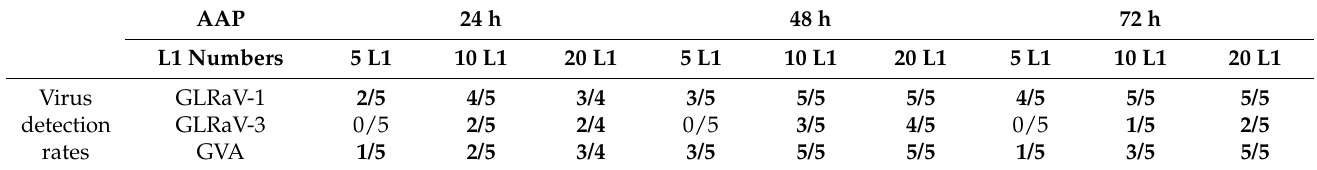
Table 8. Detection rates of GLRaV-1 and -3, and GVA in L1 nymphs of Heliococcus bohemicus , after AAP from 24 h to 72 h, with 5, 10, or 20 nymphs per batch. Number of positive batches/number of batches tested. Positive detections are highlighted in bold.